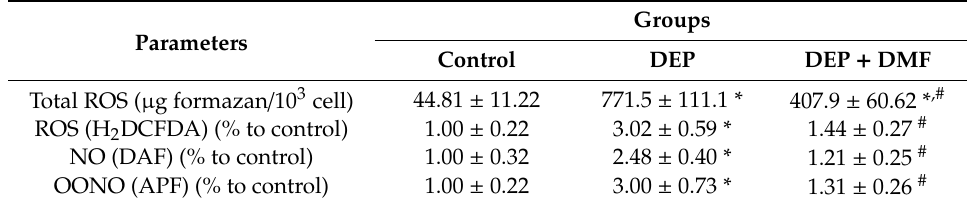
Table 1. The e ff ects of DMF treatment on oxidative and nitrosative stress markers in BAL after chronic DEP instillation.